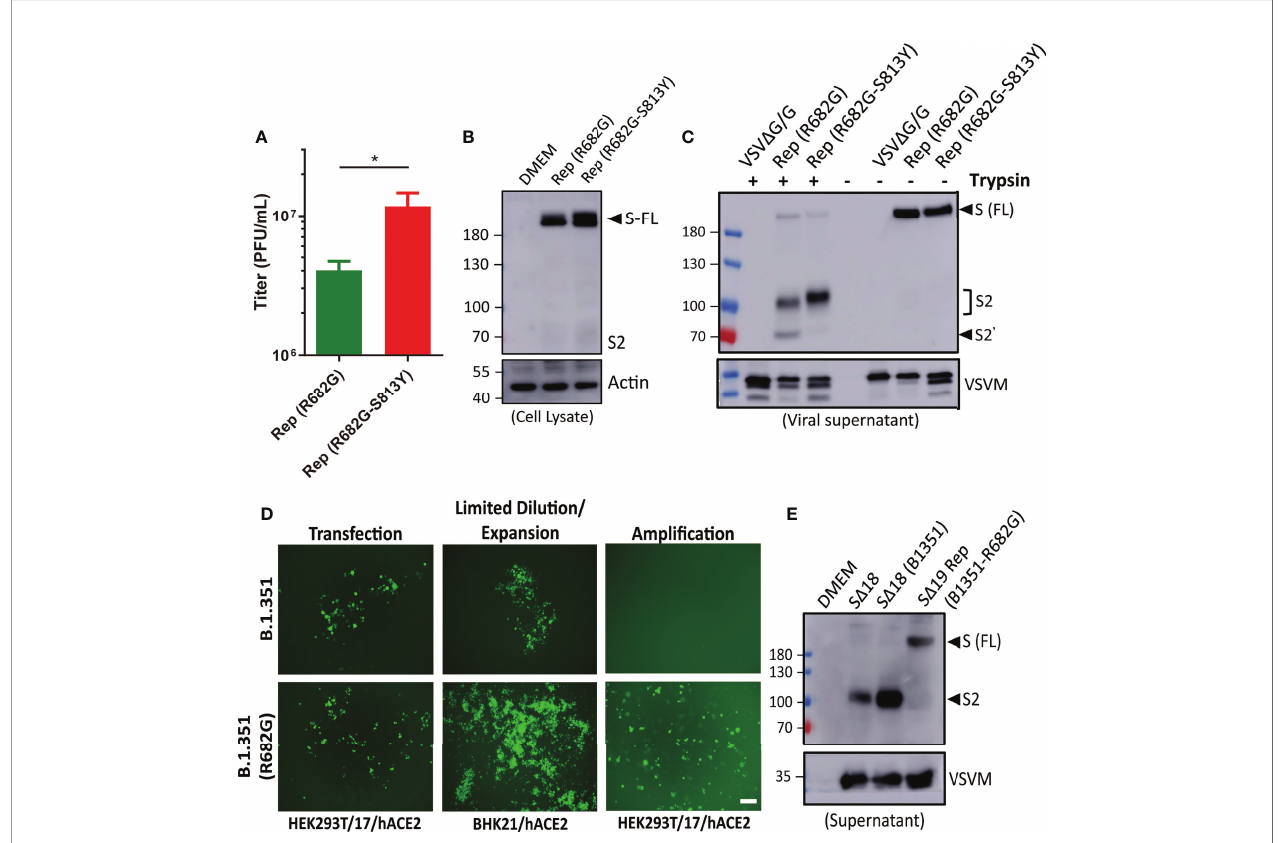
FIGURE 6 | R682G and S813Y mutations facilitate rVSV-S replication. (A) HEK293T-hACE2 cells were infected with the S D 19 Rep virus with R682G or R682G- S813Y mutation. Virus titer in the culture supernatant was measured (moi=0.1, 3 dpi, n=4). (B) Virus-infected cell lysate (moi=1, 1 dpi) was subjected to immunoblotting with anti-S2 antibodies. (C) The viral particles in the culture supernatant were digested with TPCK-trypsin (2 m g/ml at 37°C for 30 min) and analyzed by immunoblotting. (D) S D 19 beta variant (B.1.351) gene with and without R682G mutation was inserted into the VSV D G-GFP DNA vector and co-transfected with all the required helper plasmids in HEK293T-hACE2 cells to rescue recombinant VSV D G-S D 19 (B.1.351)/G virus. Virus replication was monitored by GFP expression. The rescued viruses were collected to infect BHK21-hACE2 cells with limiting dilution, and further ampli fi ed in HEK293T-hACE2 cells. (E) The Spike protein expression pattern of the replication-competent S D 19 (B.1.351-R682G) virus was examined by immunoblotting alone with S D 18 and S D 18 (B.1.351) pseudoviruses for comparison. Scale bar: 100 m m. * P <